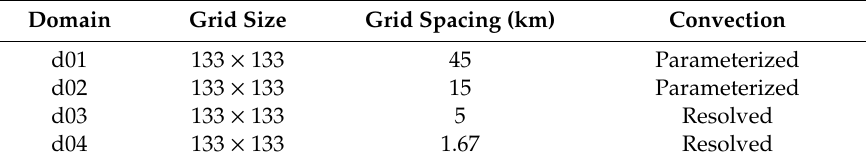
Figure 3. WRF nested-domain setup and the location of Mildura site used for model evaluation. The outer or first domain has a grid resolution of 45 km. The inner-nested second (white box) has a grid resolution of 15 km, and third and fourth (red boxes) domains have grid resolutions of 5 km and 1.7 km, respectively. Table 2. Overview of WRF model domain